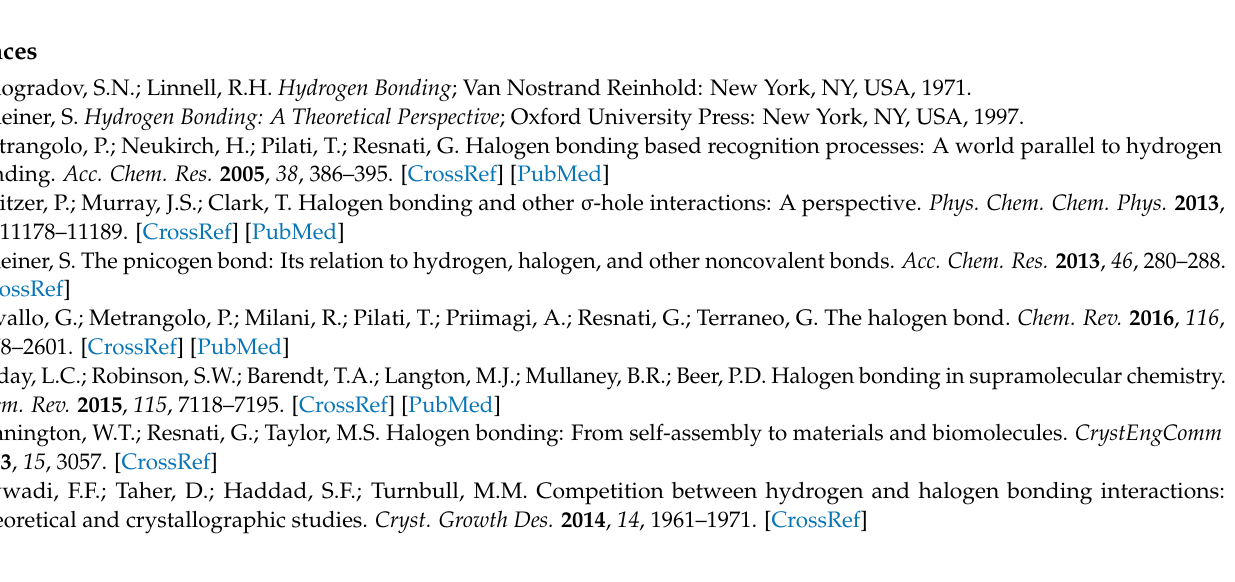
Figure S6: Fit of spectral changes in solutions of CHI 3 with TMPD and DABCO to 1:1 binding isotherm. Figure S7: Dependencies of the chemical shifts in the protons of CHI 3 on the concen- tration of added trimethylamine, N,N -dimethylaniline, 4-(dimethylamino)benzonitrile, p -bromo- N,N -dimethylaniline or 3-(dimethylamino)benzonitrile. Figure S8: Dependencies of the chemical shifts in the protons of CHBr 3 on the concentration of added trimethylamine, N,N -dimethylaniline, 4-(dimethylamino)benzonitrile, p -bromo- N,N -dimethylaniline or 3-(dimethylamino)benzonitrile. Fig- ure S9: Dependencies of the chemical shifts in the protons of CHBr 3 on the concentration of added trimethylamine, N,N -dimethylaniline, 4-(dimethylamino)benzonitrile, p -bromo- N,N -dimethylaniline or 3-(dimethylamino)benzonitrile. Figure S10. Effect of variation of interatomic H–N and X–N separations on the energy of HB and XB complexes and chemical shifts in the haloforms’ protons. Figure S11. Alternative structure of XB complex between CHI 3 and TMPD. Table S1: Values of the maximum electrostatic potentials on the surfaces of halogen and hydrogen atoms in individual and polarized haloforms. Table S2. Crystallographic, data collection and refinement details. Table S3: Energies of the HB and XB complexes and their components. Table S4: Atomic coordinate of the HB and XB complexes of haloforms with DABCO and